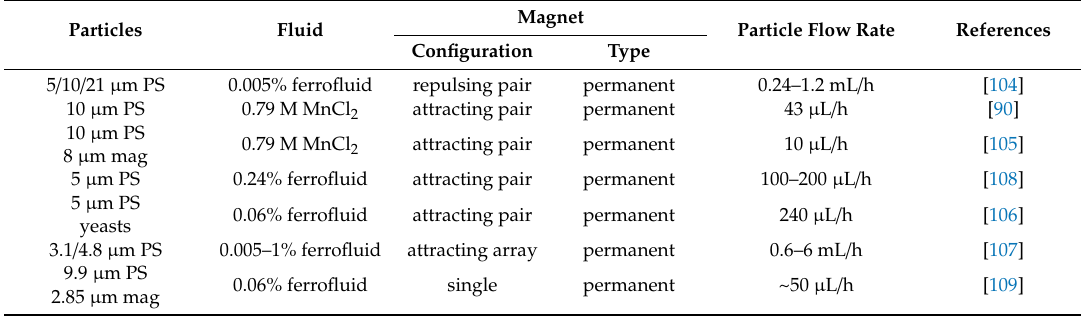
Table 3. Summary of the published papers on diamagnetic particle enrichment in magnetic fluid